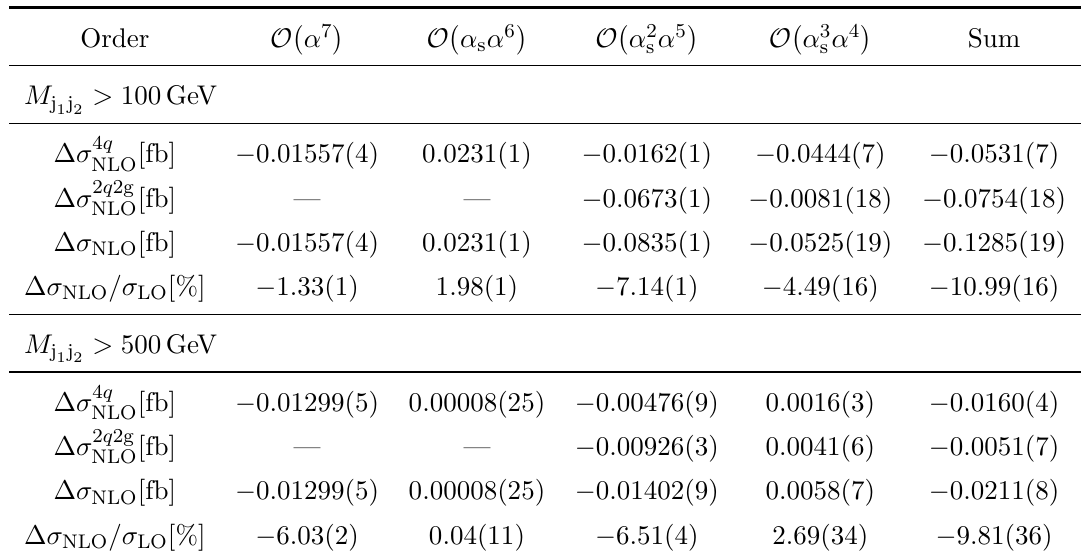
(cid:0) (cid:1) (cid:0) (cid:1) α 7 , O α s α 6 , , are shown separately. The contri- LO